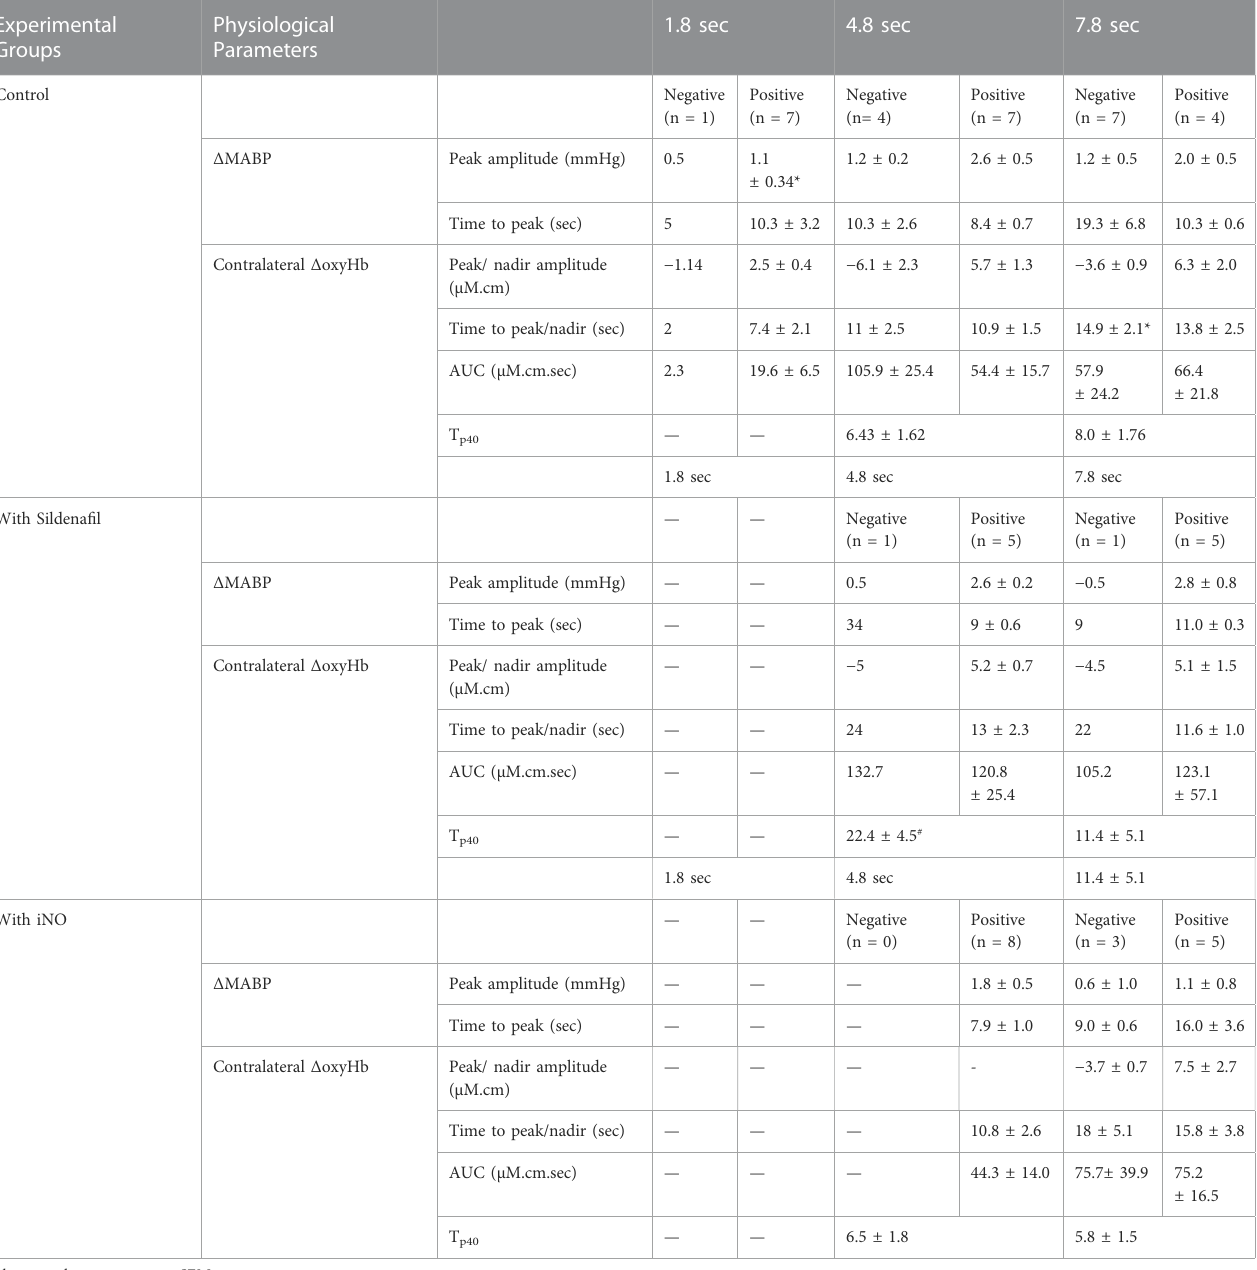
TABLE 3 Changes in physiological parameters in preterm lambs with and without sildena fi l and iNO. Changes in physiological parameters in preterm lambs with positive ornegative contralateral Δ oxyHb response,followingmediannervestimulationsfor 1.8,4.8,and7.8 sinthecontrol,sildena fi landiNOpreterm lambs(values are mean ± SEM; individual values are shown where n < 3